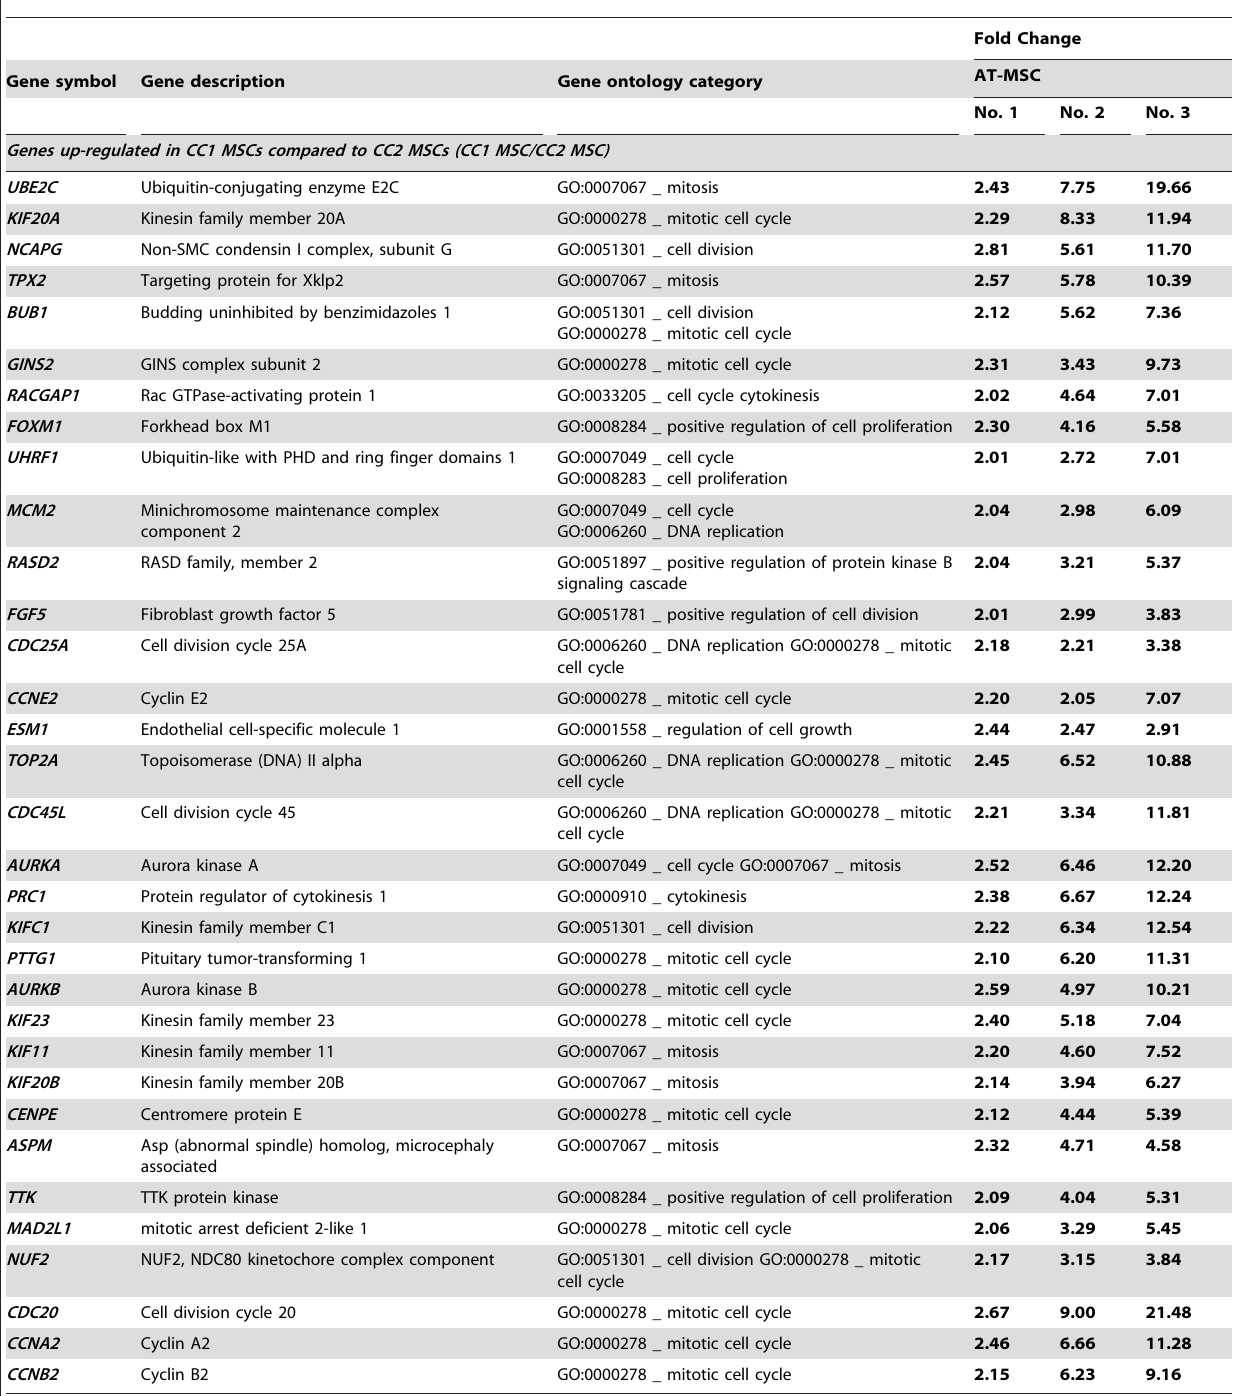
Table 3. Differentially expressed cell proliferation-associated genes in AT-MSCs from three different donors, cultured to low or high density, as determined by microarray